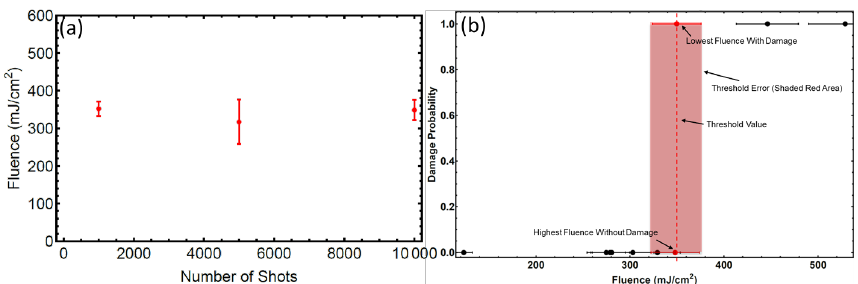
Figure 1. LIDT of silicon (111) vs. number of shots. ( a ) LIDT fluence vs. number of shots for Si; ( b ) example of damage threshold determination method for 10,000 shots. The LIDT here is considered to be the average of the highest fluence with zero damage probability and the lowest fluence with 100% damage